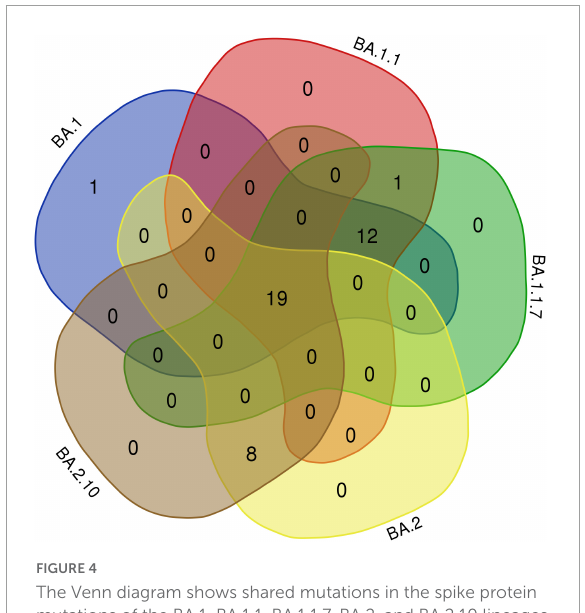
FIGURE4 The Venn diagram shows shared mutations in the spike protein mutations of the BA.1, BA.1.1, BA.1.1.7, BA.2, and BA.2.10 lineages FIGURE5